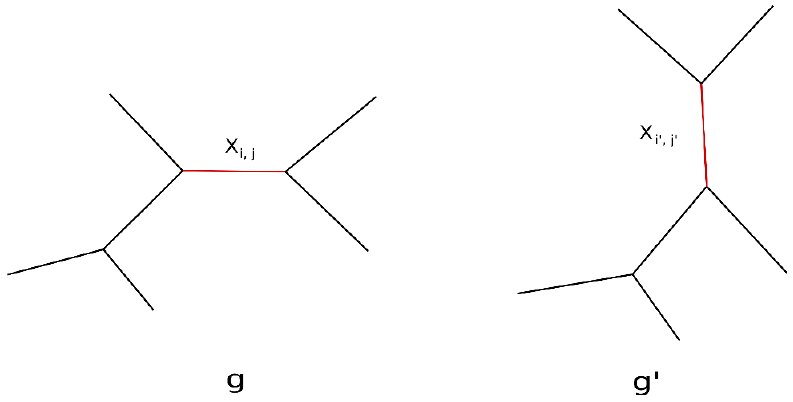
Figure 5 . Two 5-point graphs related by mutation: X